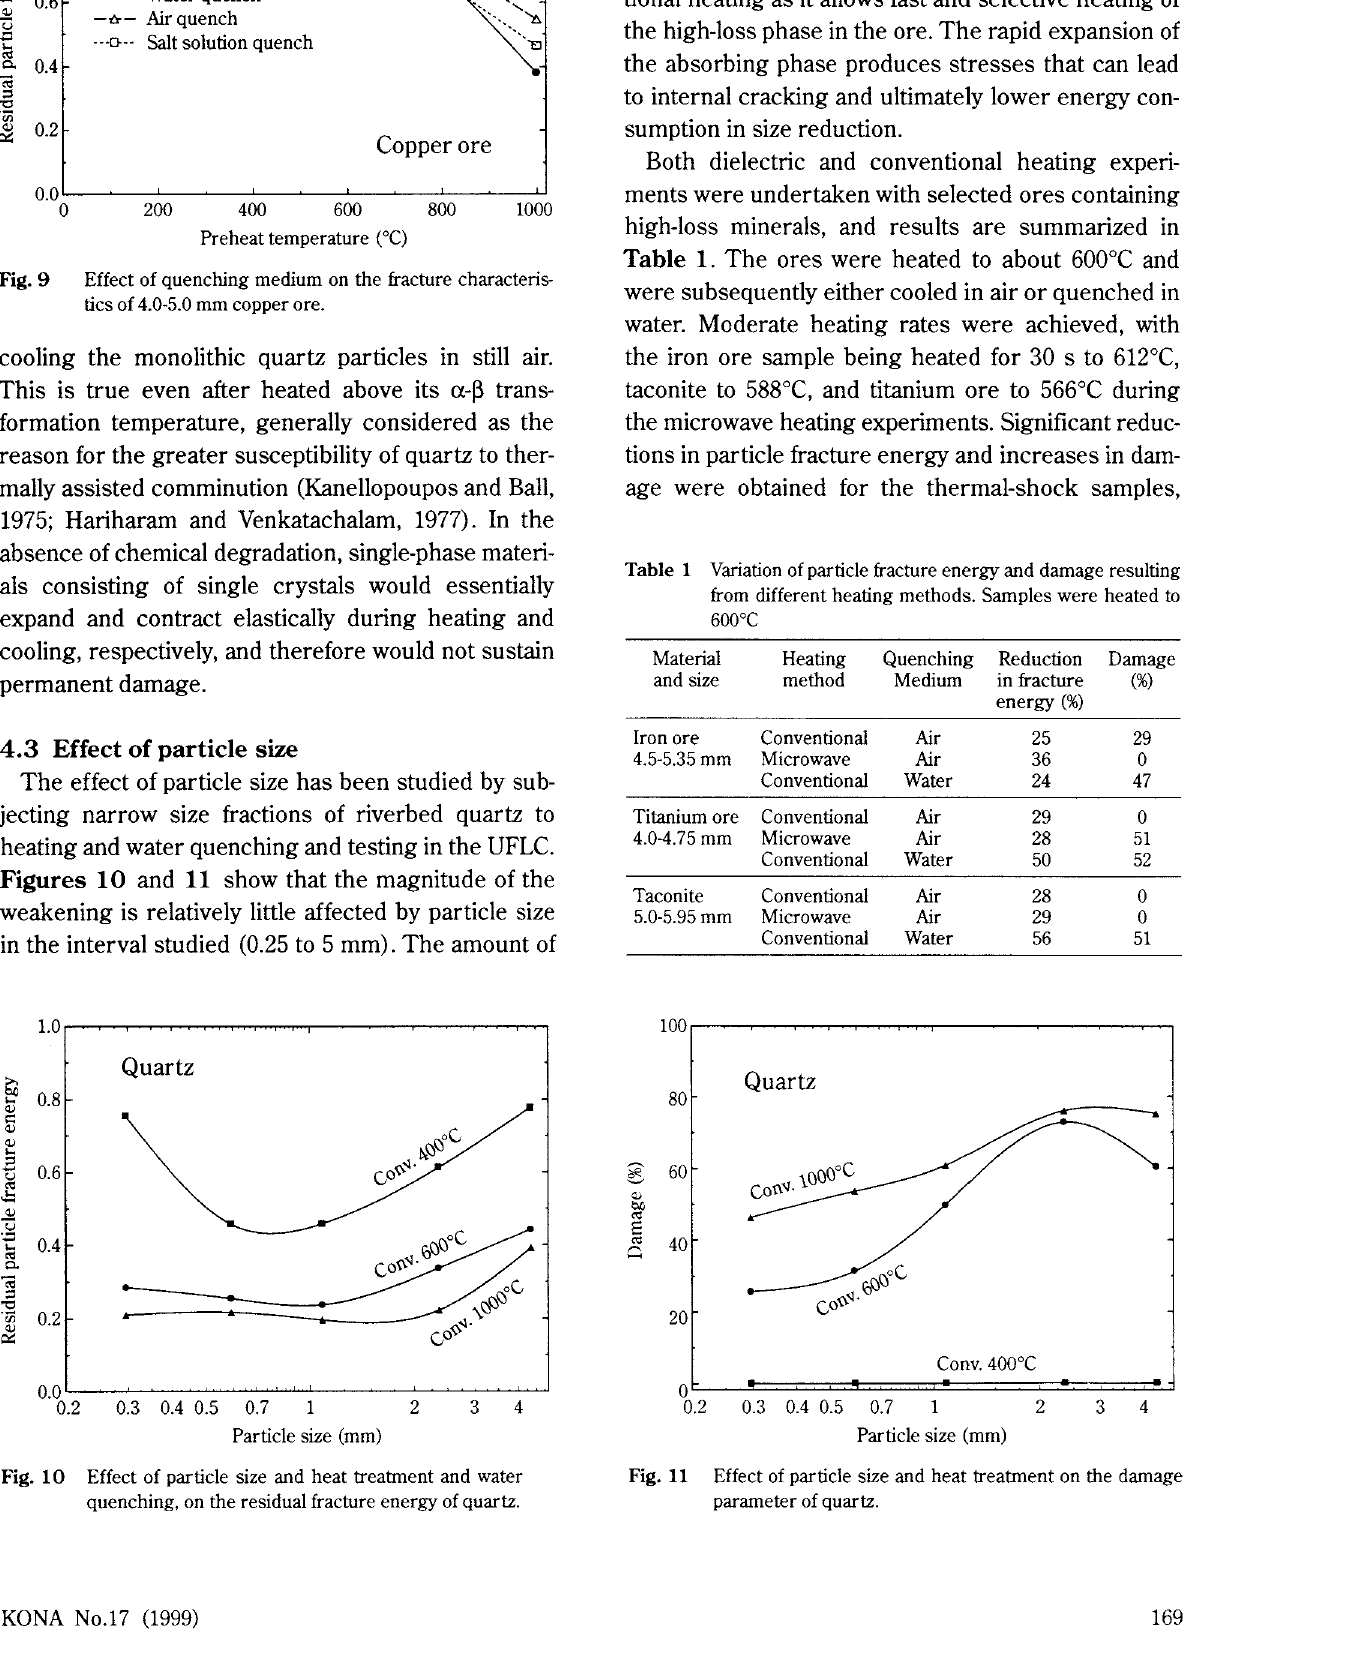
Fig. 11 Effect of particle size and heat treatment on the damage parameter of